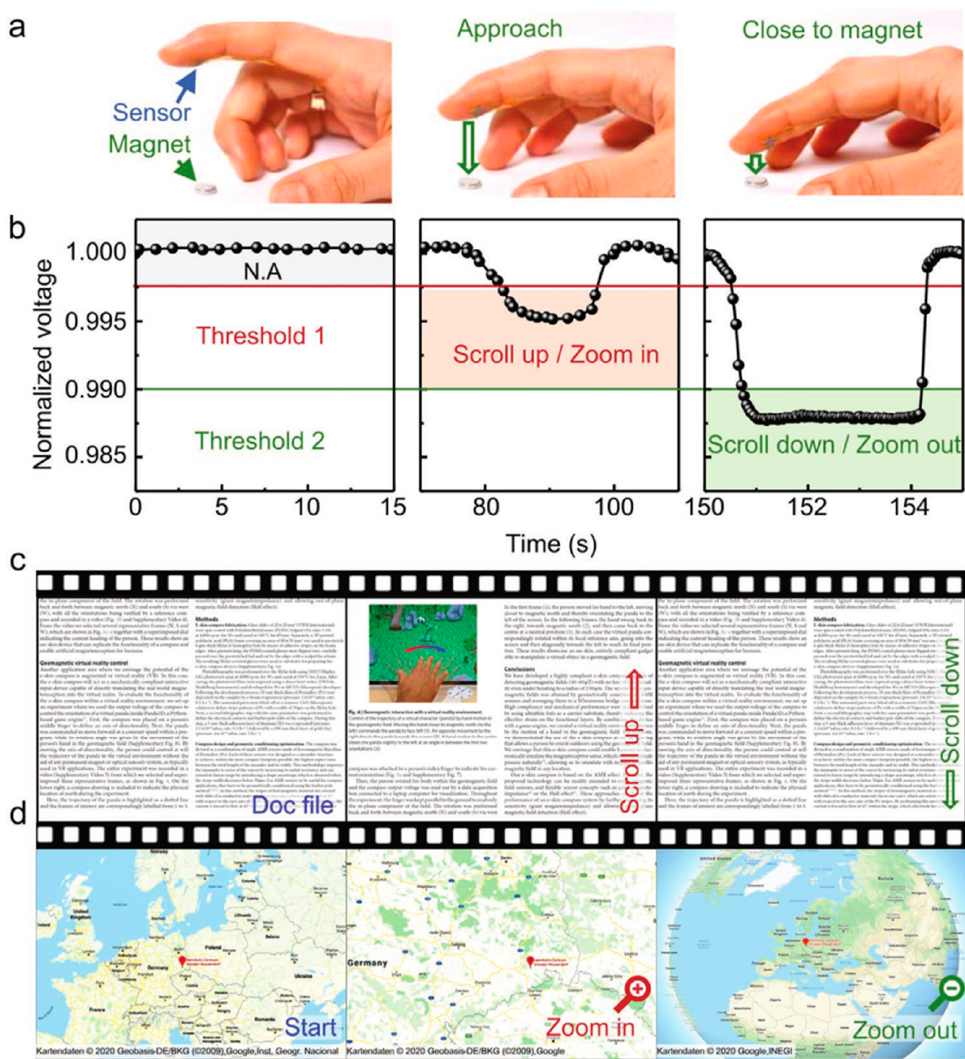
Figure 19. Highly flexible printed GMR sensors for Non-contact Interactive Platform. ( a ) A compliant printed GMR sensor attached to the finger which can read displacement of a permanent magnet; ( b ) The time evolution of the normalized sensor read out dependent on the distance between the finger and the magnet; The sensor signal is used to navigate through the document ( c ) or zoom in/out the map ( d ). Adapted with permission from Ref. [72] and licensed under CC BY 4.0. Copyright 2021, copyright John Wiley & Sons, Inc.